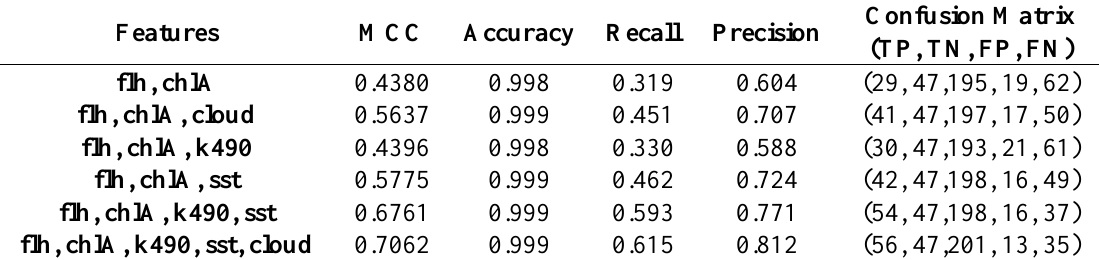
Table 2. Test results based on Random